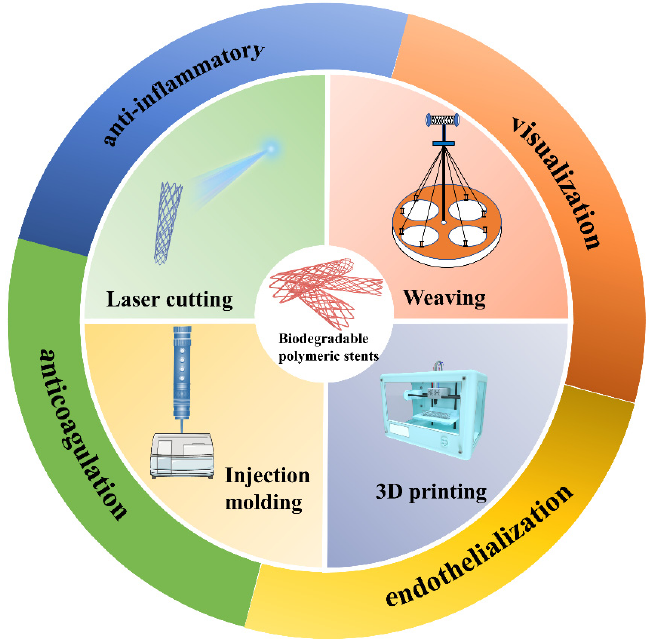
Figure 1. Current research progress in biodegradable polymeric